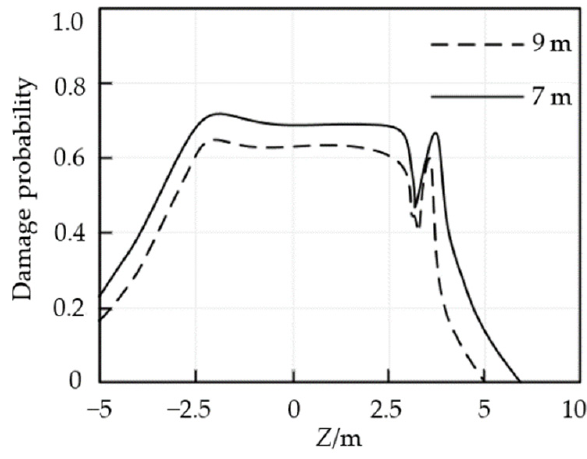
Figure 4. The damage probability calculation results under different distance. According to the calculation results in Figure 4, it can be seen that when the distance between the projectile explosion position and the target is relatively short, the damage prob- ability of the corresponding vulnerable parts is relatively high, which is mainly reflected in the